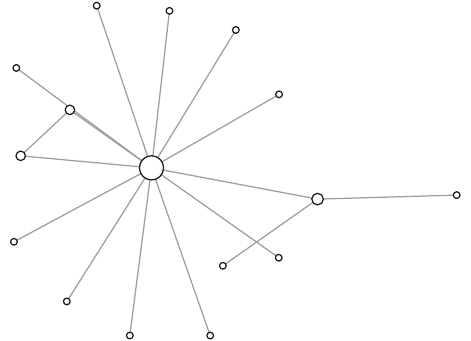
4: Newman modular network of size 16